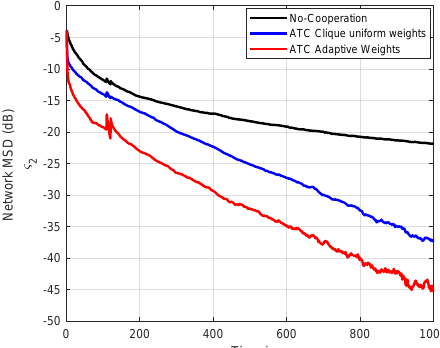
Figure 6. Network MSD (dB) for the w (global) and commons ς